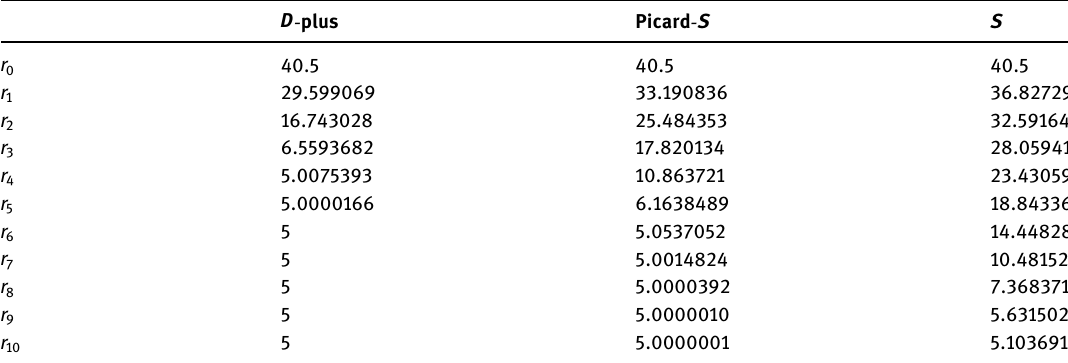
Table 1: Convergence of D - plus, Picard - S , and S iteration processes in Example 1 D - plus Picard - S S r